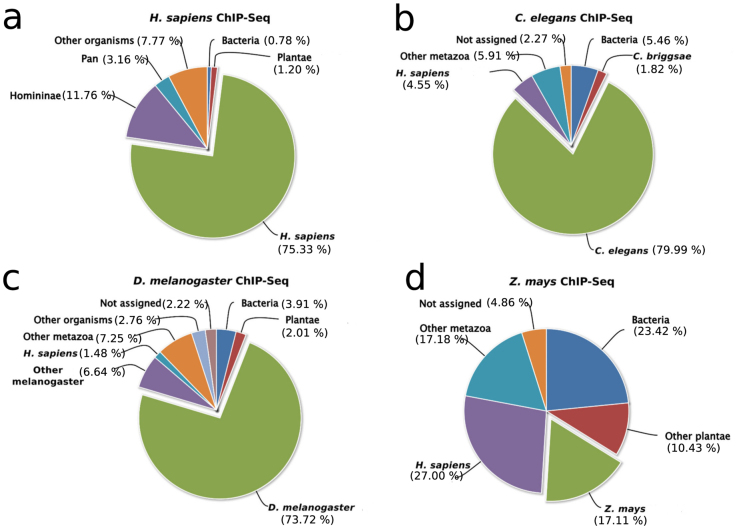
Taxonomic classification of previously unaligned reads datasets having potentially legitimate reads.Unaligned reads from selected H. sapiens (panel a), C. elegans (panel b), D. melanogaster (panel c) and Z. mays (panel d) ChIP-Seq runs were taxonomically classified to different taxonomic units.